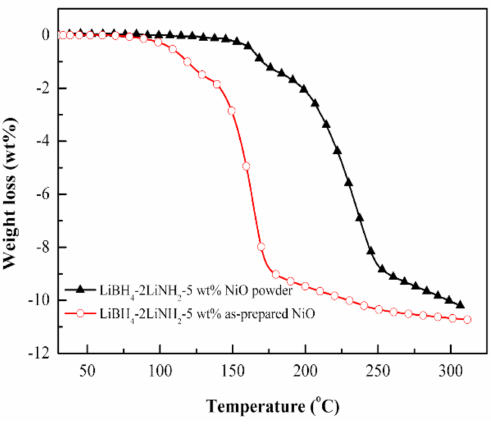
Figure 5. PCT curves of 5 wt. % as-prepared NiO and 5 wt. %NiO powder-added LiBH 4 -2LiNH 2